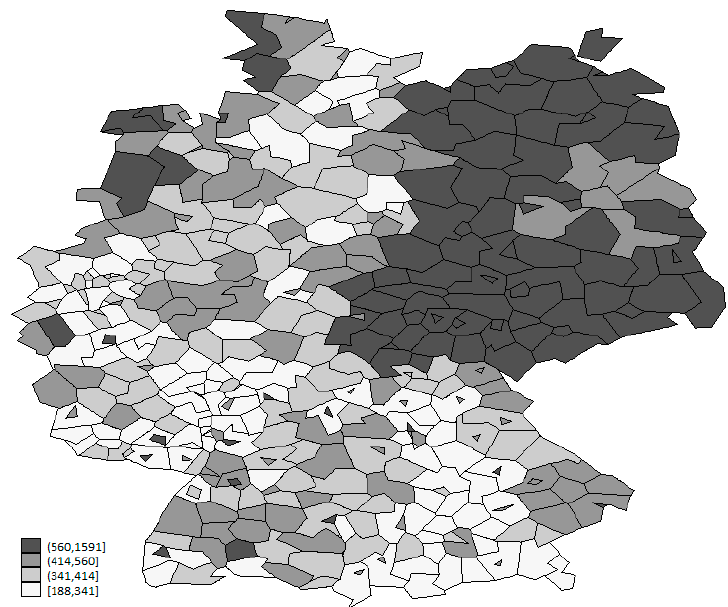
Figure 3. Public funds with a potential impact on regional development per inhabitant in German districts (Euro per inhabitant). Table 2. Funds with a Potential Impact on Regional Development in Euro per Capita and Period.